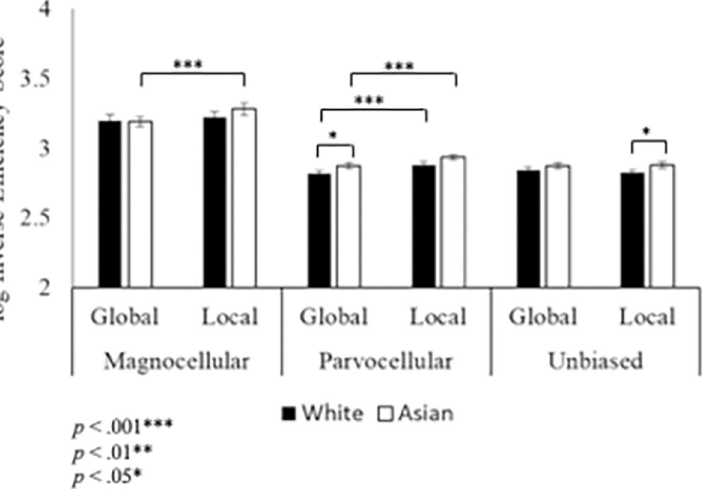
Fig 3. Inverse efficiency score results. Between groups, the target was identified faster at the global level compared to the local level in the parvocellular condition for White participants and in both the parvocellular and magnocellular conditions for Asian participants. Error bars show +/- 1